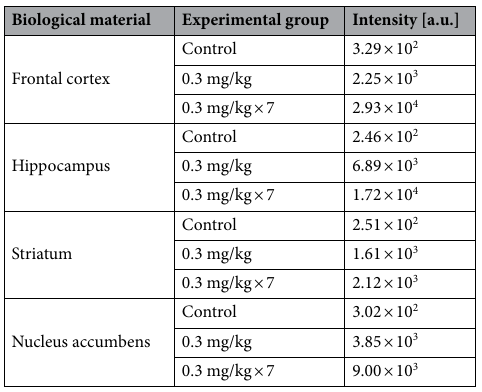
Table 2. Intensity of the 25I-NBOMe precursor ion (~ 428 m/z) from one sample preparation. The analysis was performed 72 h after a single and chronic injection (0.3 or 0.3 mg/kg × 7) with 25I-NBOMe. Values are presented as intensity per 1 mg of wet tissue; a.u. arbitrary units.